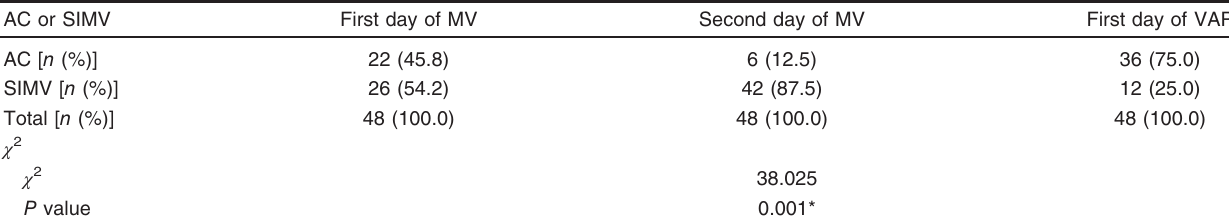
Table 6 Mode of ventilation on the first day of mechanical ventilation, the second day of mechanical ventilation, and on the first day of ventilator-associated pneumonia